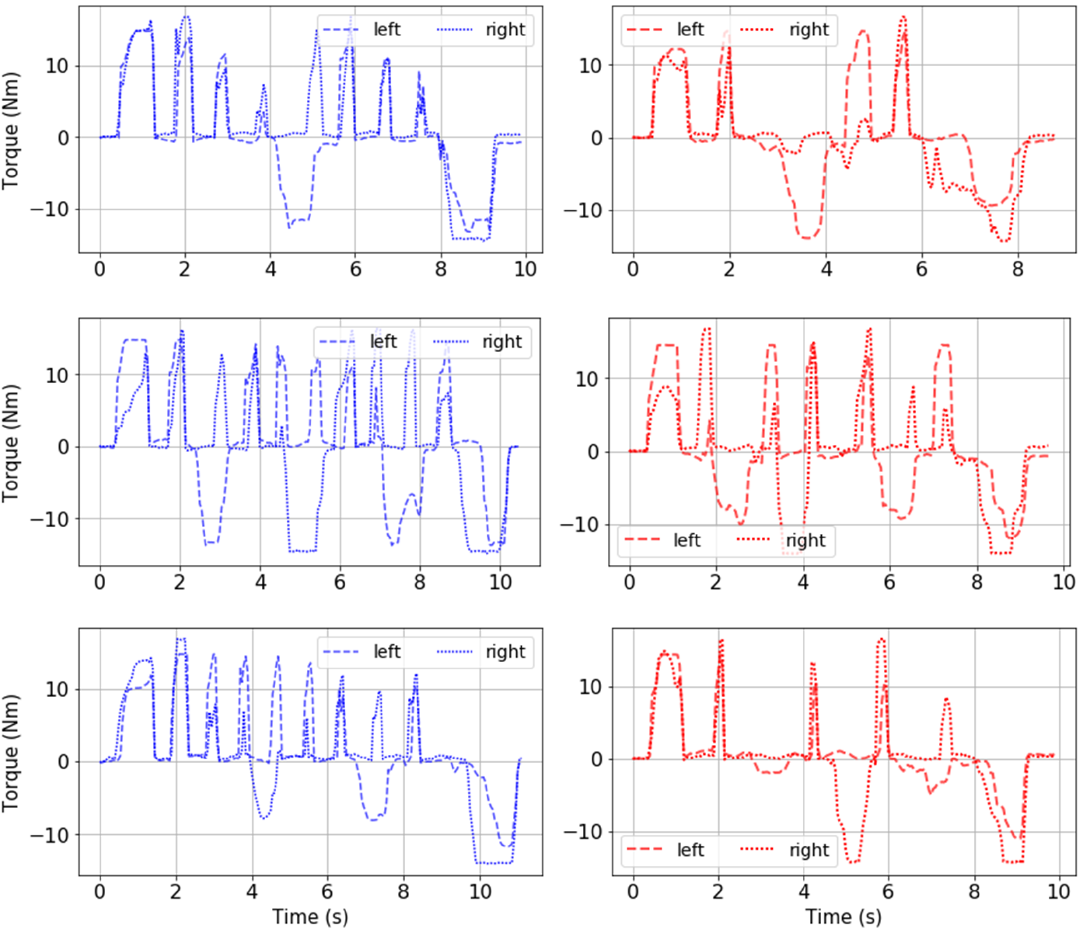
Figure 4. Kinetic characteristics of a subset of MWC tests ( left ) and PAPAW tests ( right ) for Participant 3. Wheelchair maneuvers from top to bottom: “Straight forward”, “Turn 90° right”, “Turn 90° left”, “Avoid obstacles 1.5 m”, “Avoid obstacles 3.5 m”.